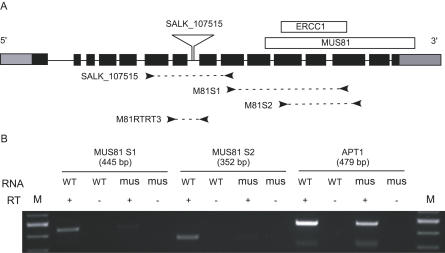
The AtMUS81 Gene Structure, T-DNA Insertion Mutant, and Expression(A) An illustration of the AtMUS81 (At4g30870) locus showing the exon/intron organization of AtMUS81. Solid boxes represent transcribed regions including protein coding (black) and untranslated regions (gray). The T-DNA insertion site for the mutant used in this study is shown. Conserved domains are shown above. Below are products for the following primers that were used for genotyping (M81_F/M81_R), RT-PCR (M81S1_F/M81S1R and M81S2_F/M81S2_R), and real-time qPCR (M81RTRT3_F/M81RTRT_R).(B) Whole seedling (10-d) RT-PCR of wild type and the Atmus81 mutant. Primers (S1 and S2) downstream of the T-DNA insertion site were used in the RT-PCR reaction with and without reverse transcriptase (RT) using RNA from wild-type (WT) and mutant (mus) plants. The APT1 transcript was used as a control.